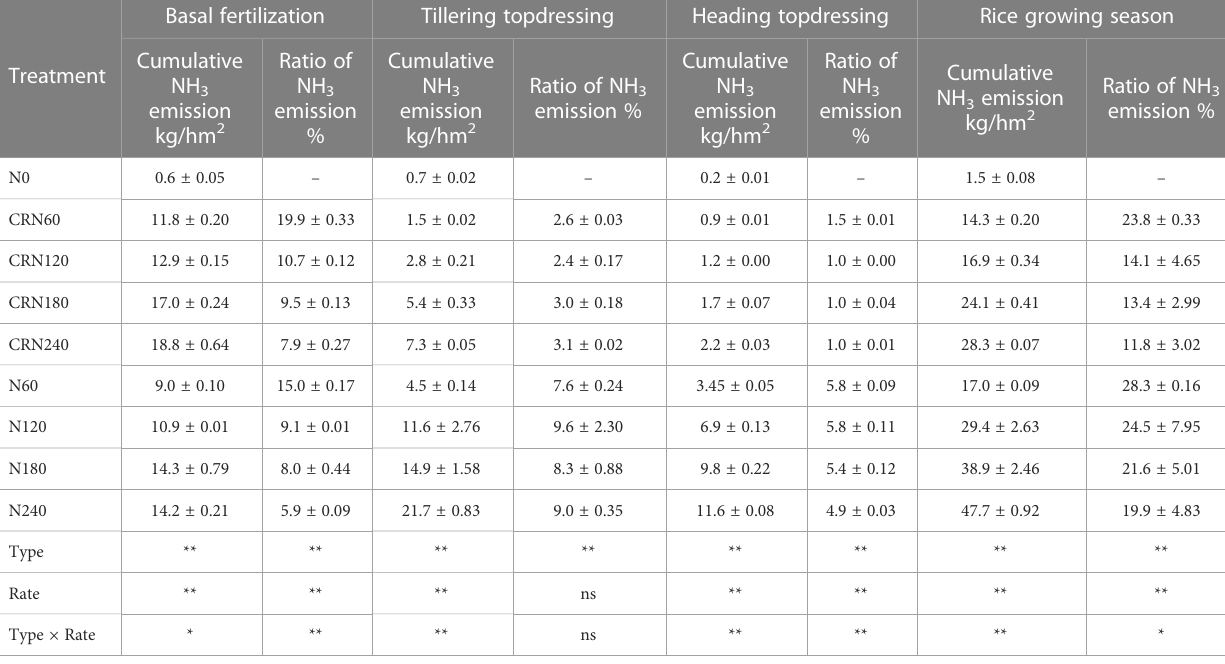
TABLE 3 Cumulative NH 3 emissions and the ratio of NH 3 emissions under different N fertilizer treatments in the 2019 rice season.